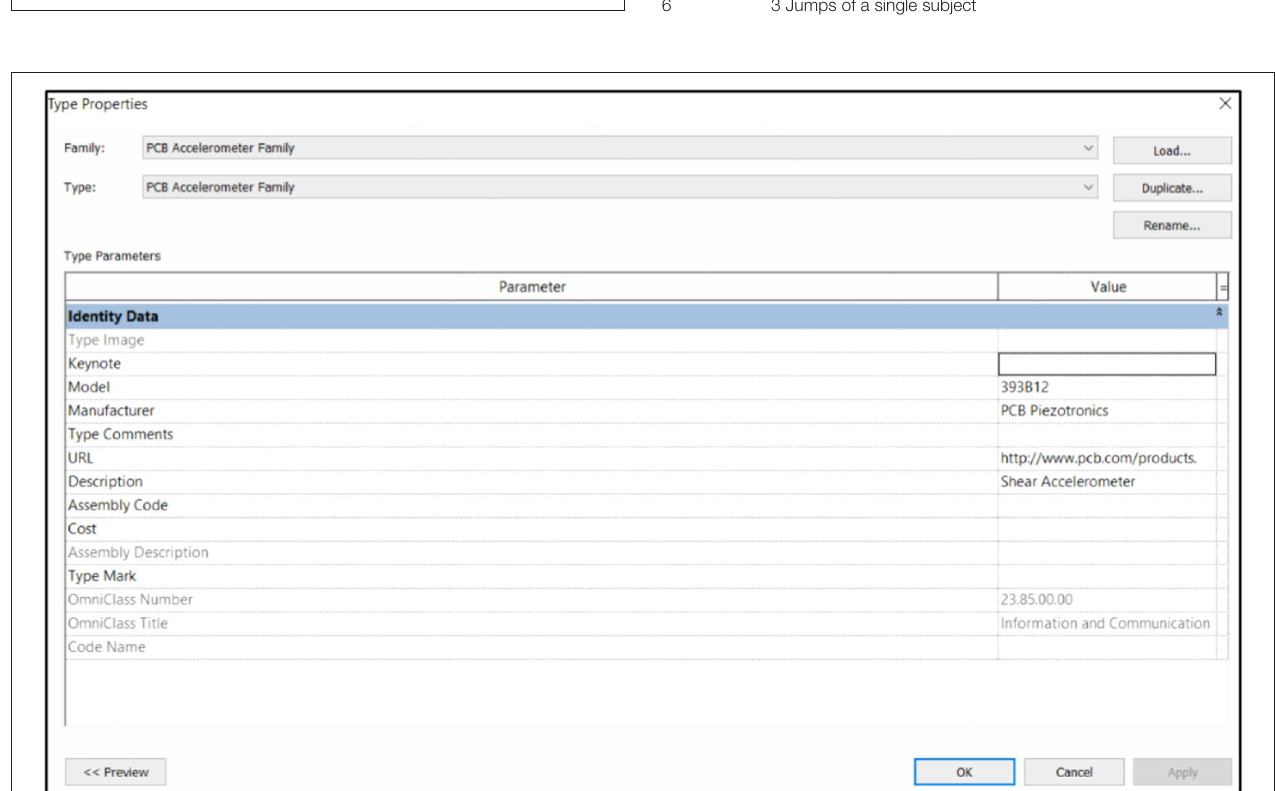
FIGURE 7 | Sensor metadata defined in Autodesk